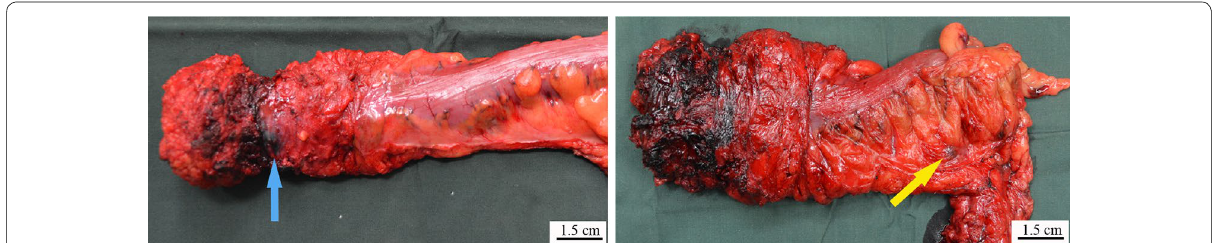
Fig. 1 Gross specimen of rectal cancer removed under laparoscopy after injection of carbon nanoparticle suspension. The left shows the stained periphery which should be protected from damage during the operative procedures; the right shows the stained lymph node. The blue arrow indicates the interface of the resection; the yellow arrow indicates the dyed lymph node